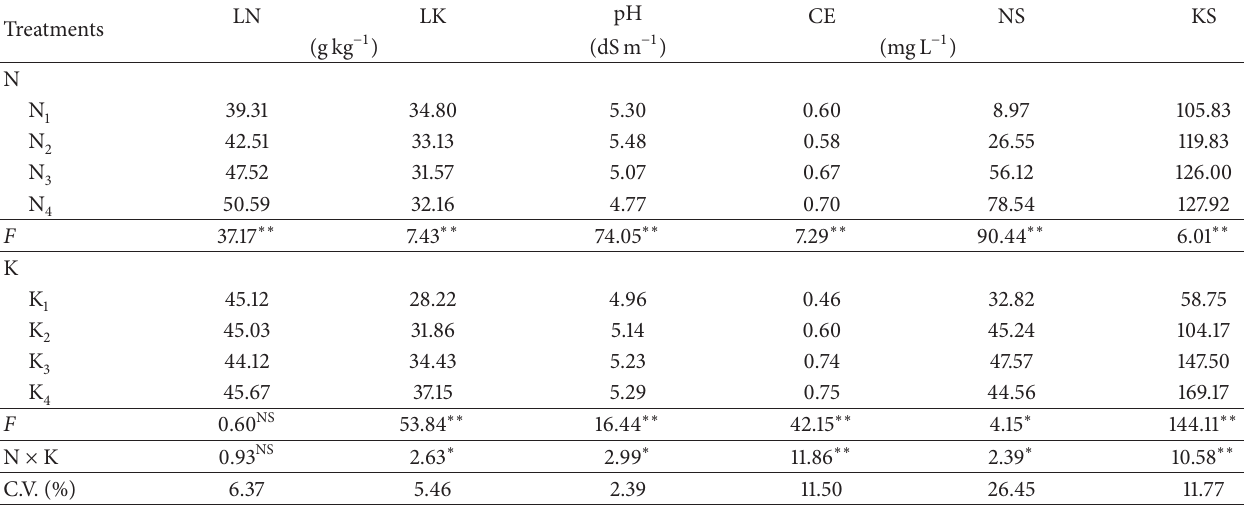
Table2:Analysisofvarianceresultsfornitrogenleaflevel(LN)andpotassiumleaflevel(LK),N-NO 3−